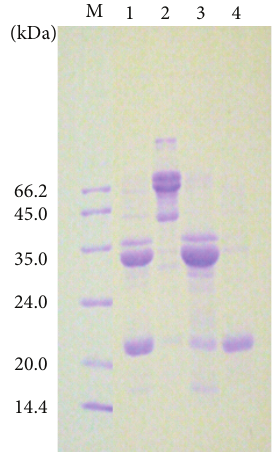
Figure 1: SDS-PAGE patterns of soy 11S globulin acid subunits.